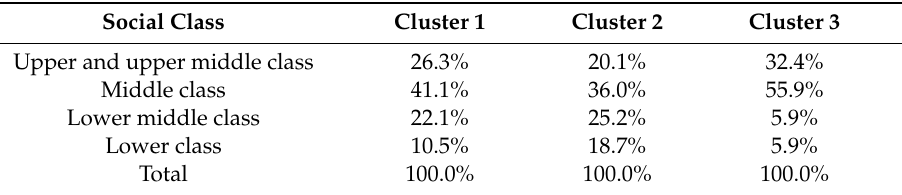
Table 8. Crosstab for cluster membership and Social Class variable.